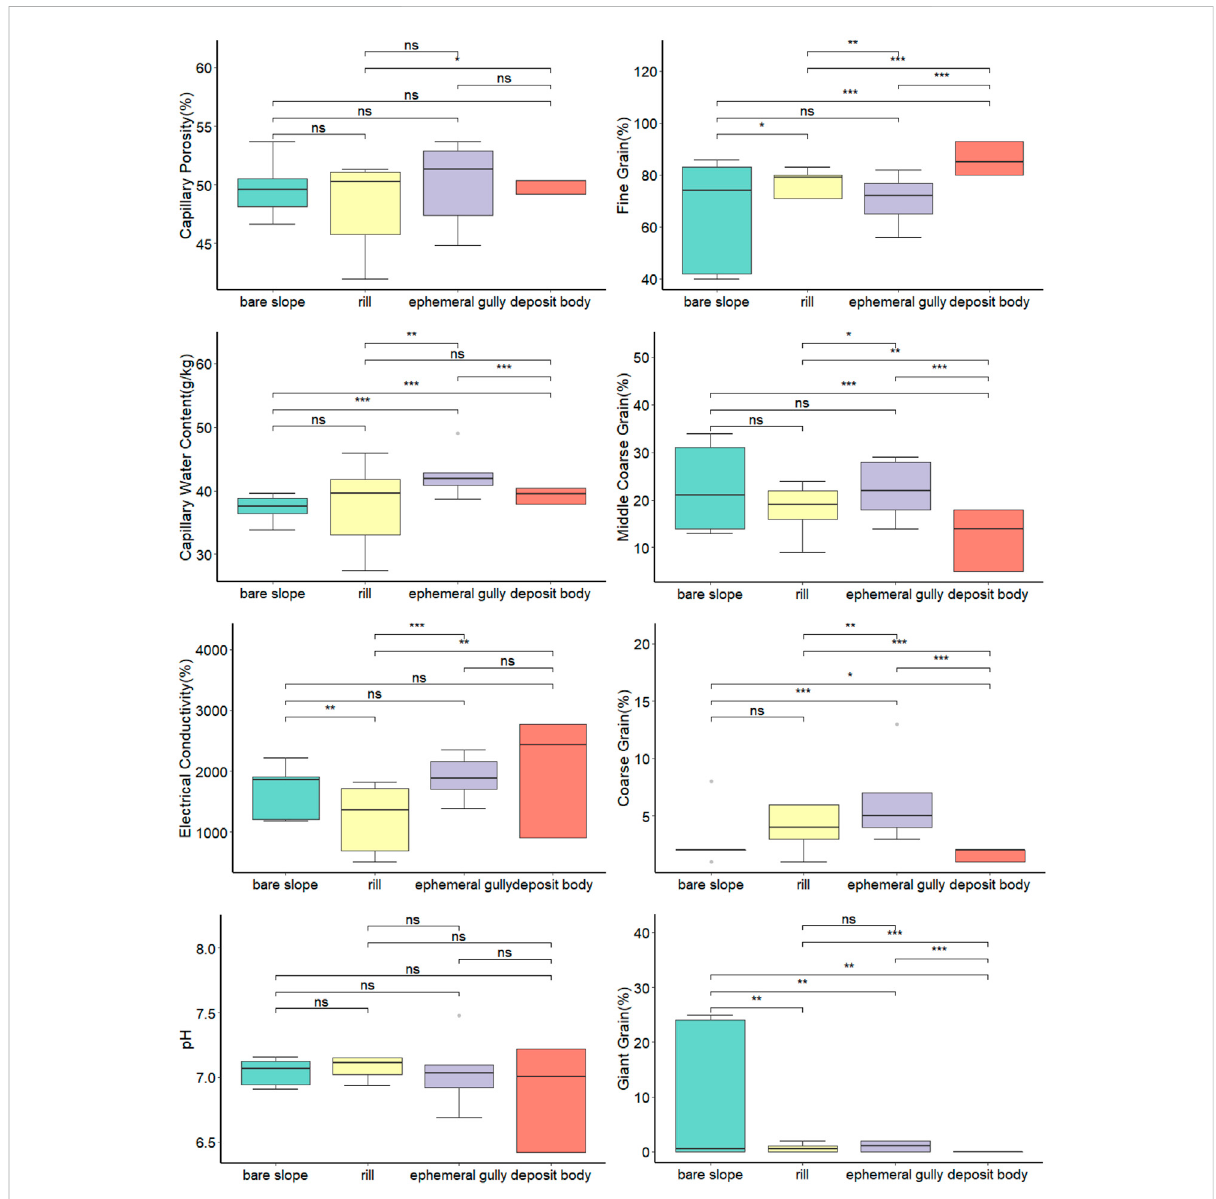
FIGURE 3 Substrate physicochemical properties in the micro-topographies. *, **, and *** indicate signi fi cant differences between the two micro- topographies at p < 0.05, p < 0.01, p < 0.001 levels, respectively; ns, non-signi fi cant difference. The signi fi cance was tested at different probability levels ( P ) by Student ’ s